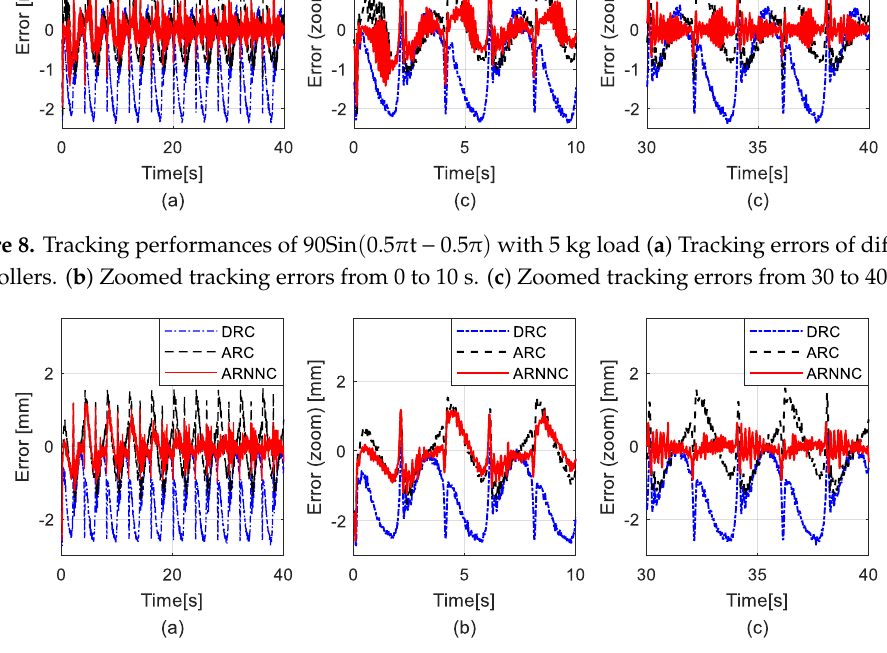
Figure 9. Tracking performances of 90Sin ( 0.5 π t − 0.5 π ) with 8 kg load ( a ) Tracking errors of di ff erent controllers. ( b ) Zoomed tracking errors from 0 to 10 s. ( c ) Zoomed tracking errors from 30 to 40 s.